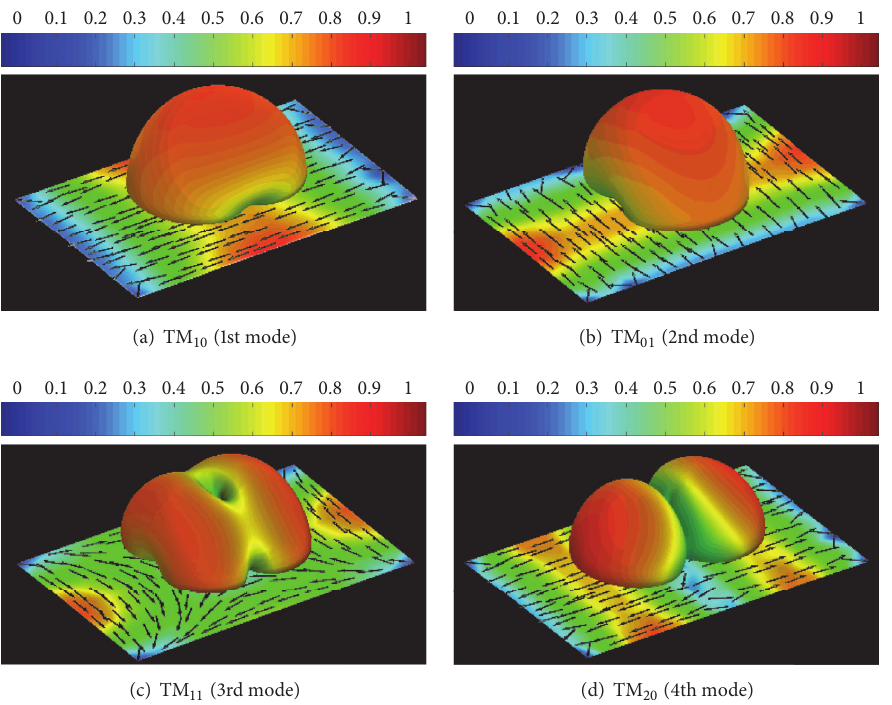
Figure 2: The characteristic currents and fields of the rectangular patch with grounded dielectric substrate ( 𝜀 𝑟 = 3.38